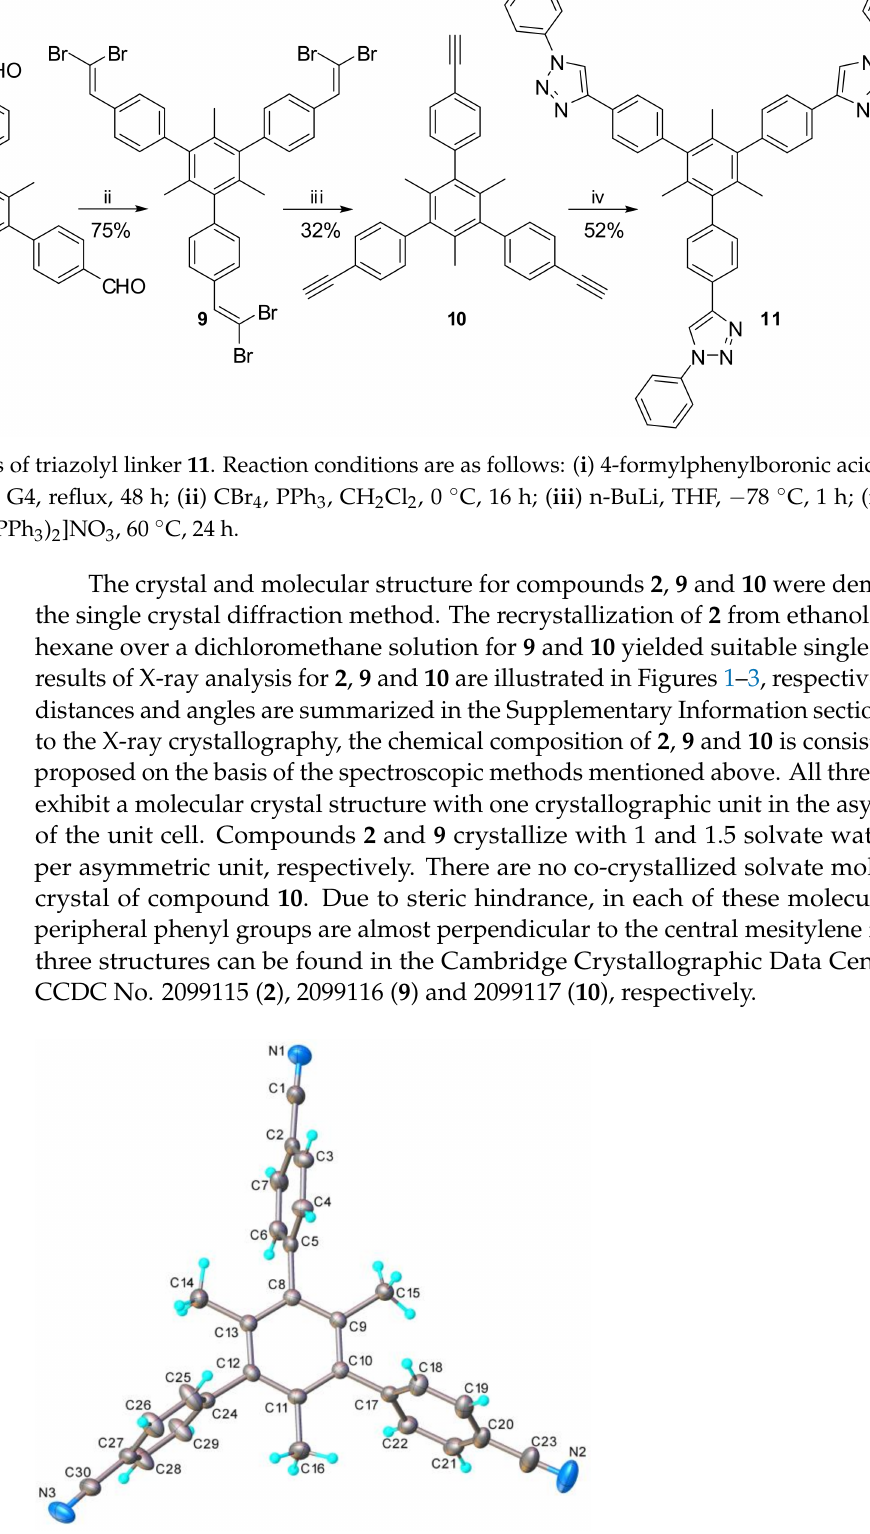
Figure 1. X-ray molecular structure of 2 with atom labeling and thermal ellipsoids at 40%